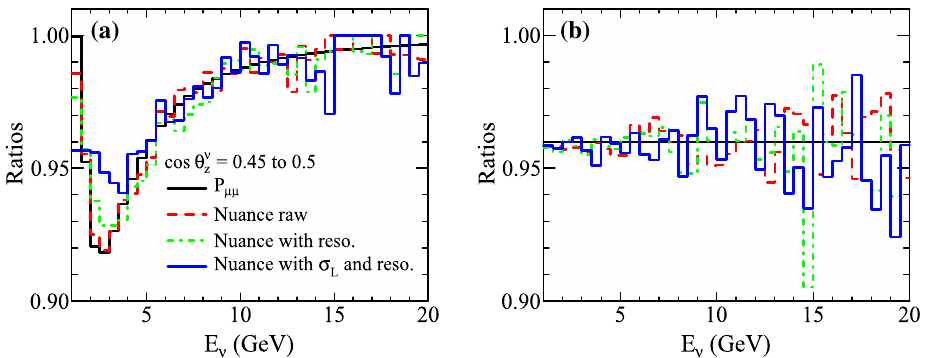
Fig. 3 The ratio of oscillated to unoscillated events versus neutrino energy for the cos θ z bin 0.40–0.45. The active–sterile oscillation parameters are taken as θ 14 = θ 34 = 0, sin 2 2 θ 24 = 0 . 083 and a (cid:2) m 2 = 0 . 1eV 2 , b (cid:2) m 2 = 10 . 0eV 2 . The black solid lines show 41 41 the plot using the neutrino oscillation formula, the red dashed lines show the plot obtained using the NUANCE events without implement-